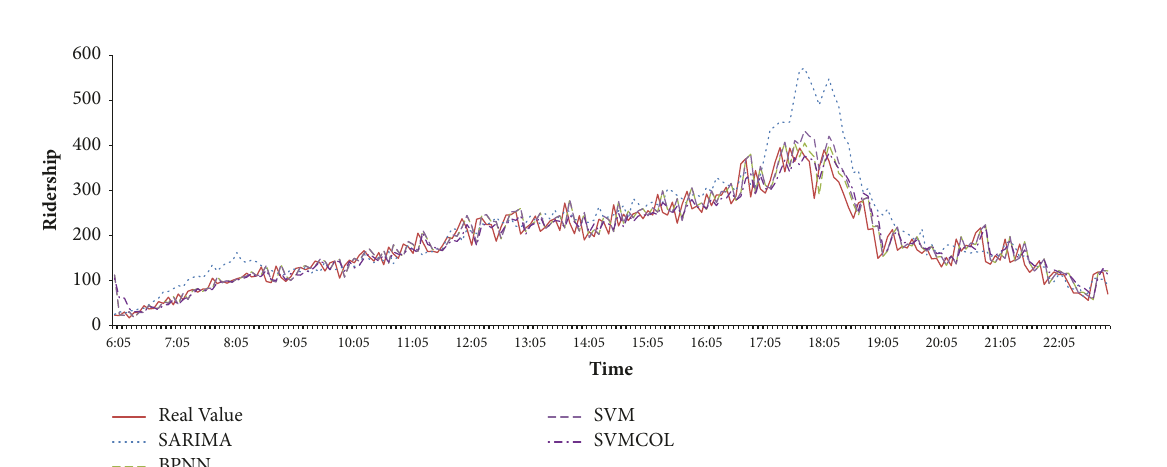
Figure 7: The comparison between the real value and the predicted values by 4 different models using origin ridership time series at Zhuji- anglu Station on May 5,